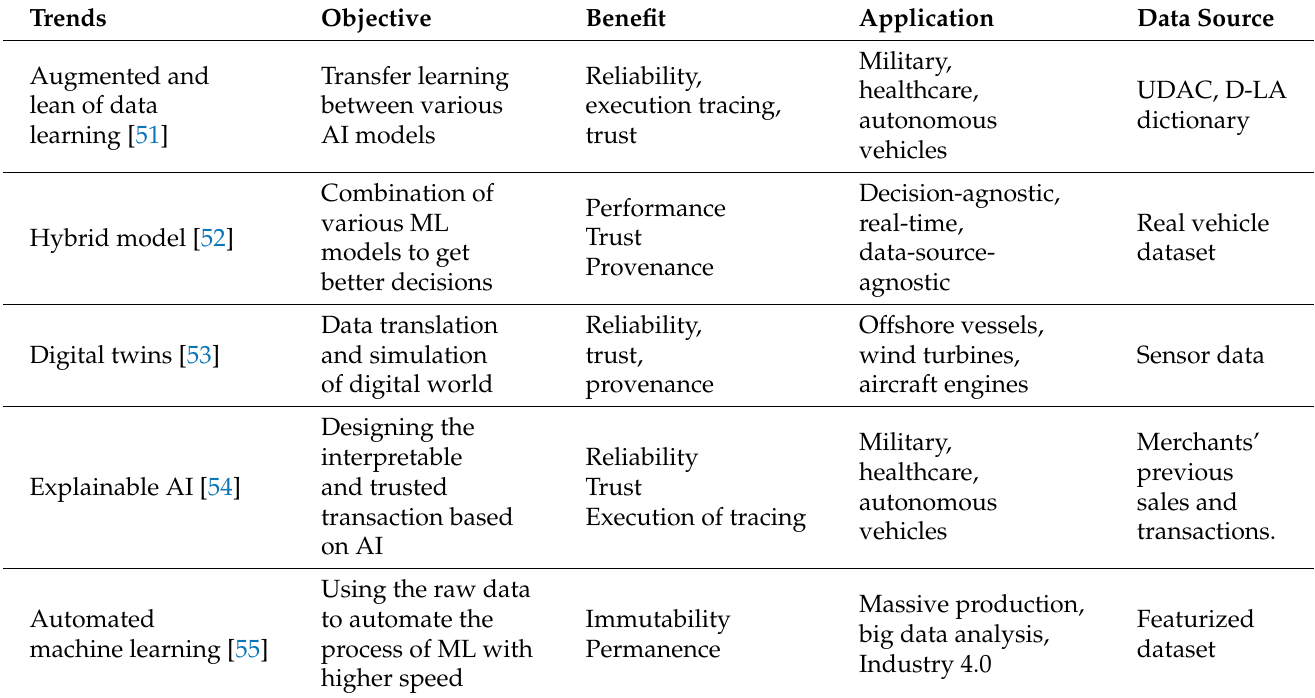
Table 1. Latest AI application trends using blockchain technology.